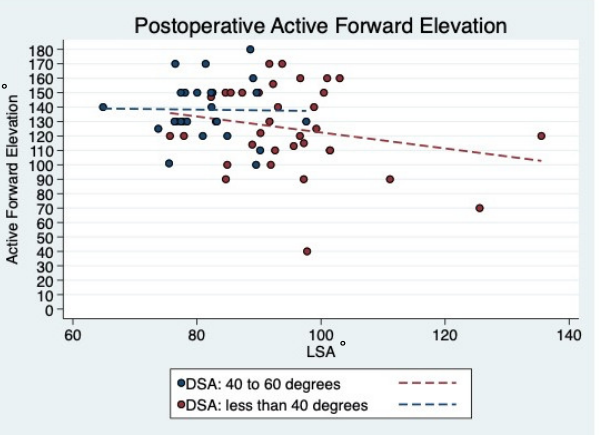
Figure 7. Scatterplot showing the linear correlation between DSA and LSA for final AFE. Good final AFE could be seen for DSA between 40 and 60° and LSA between 80 and 100°; Abbreviations: DSA = distalization shoulder angle; LSA = lateralization shoulder angle; AFE = active forward ele- vation.